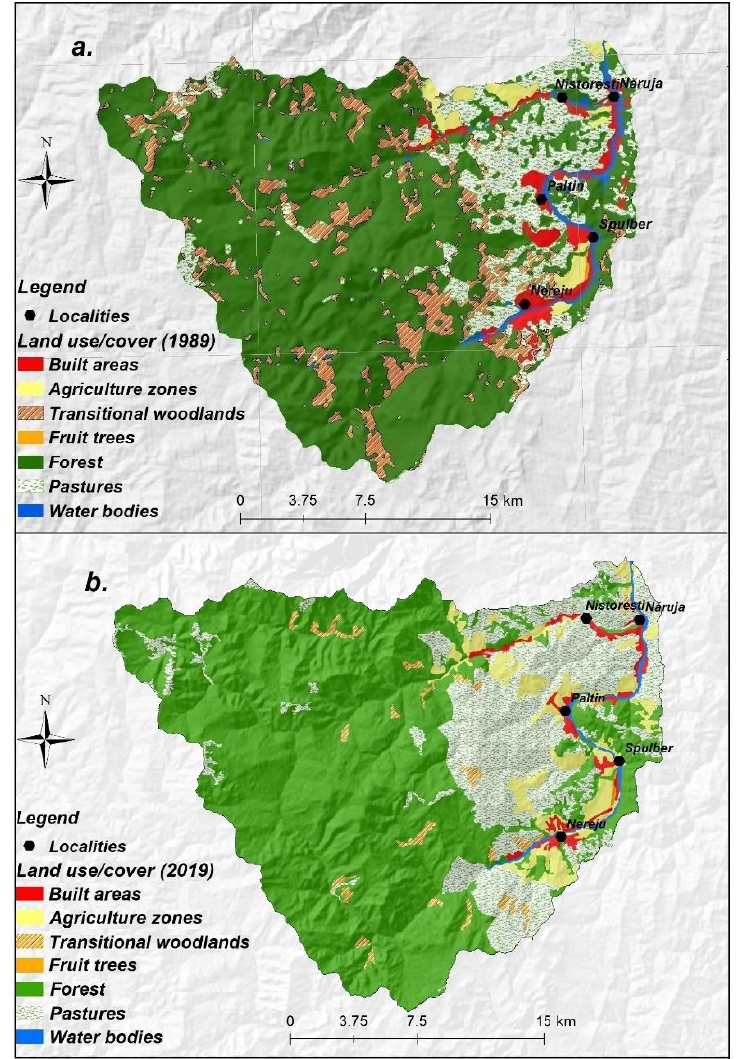
Figure 7. Land use/land cover: ( a ) 1989 and ( b ) 2019. Figure 7. Land use / land cover: ( a ) 1989 and ( b )